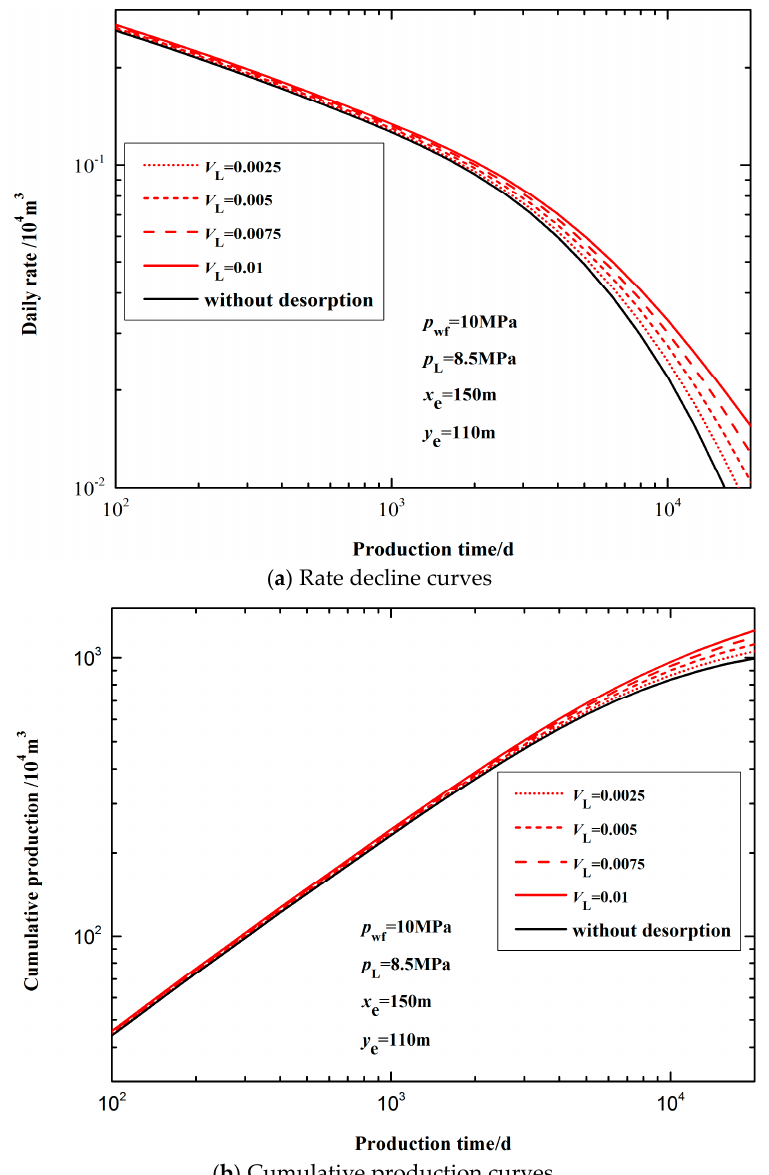
Figure 8. Effects of Langmuir volume value on production behavior.